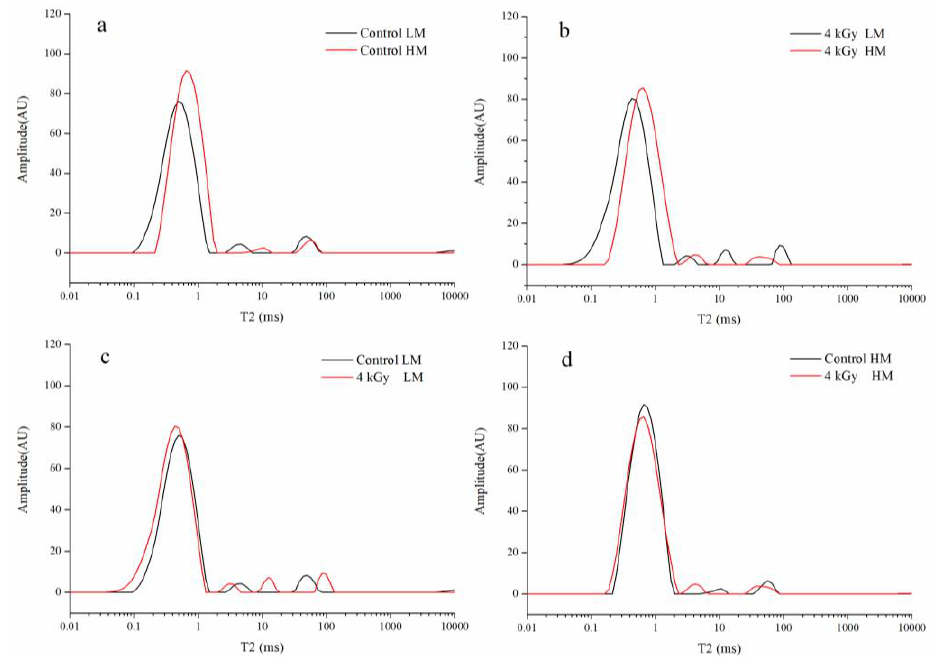
Figure 1. Water distribution in low moisture (LM) and high moisture (HM) rice samples under di ff erent irradiation doses. ( a ) Control LM and HM rice, ( b ) 4 kGy LM and HM rice, ( c ) Control and 4 kGy LM rice, ( d ) Control and 4 kGy HM rice.